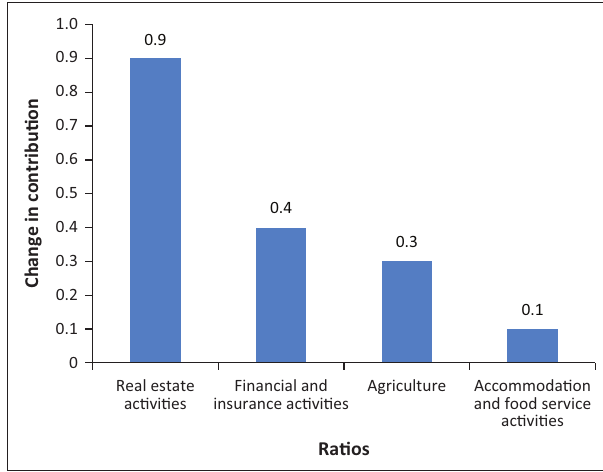
FIGURE 4: Change in contribution for 75th percentile and upwards: Foreign-held companies.